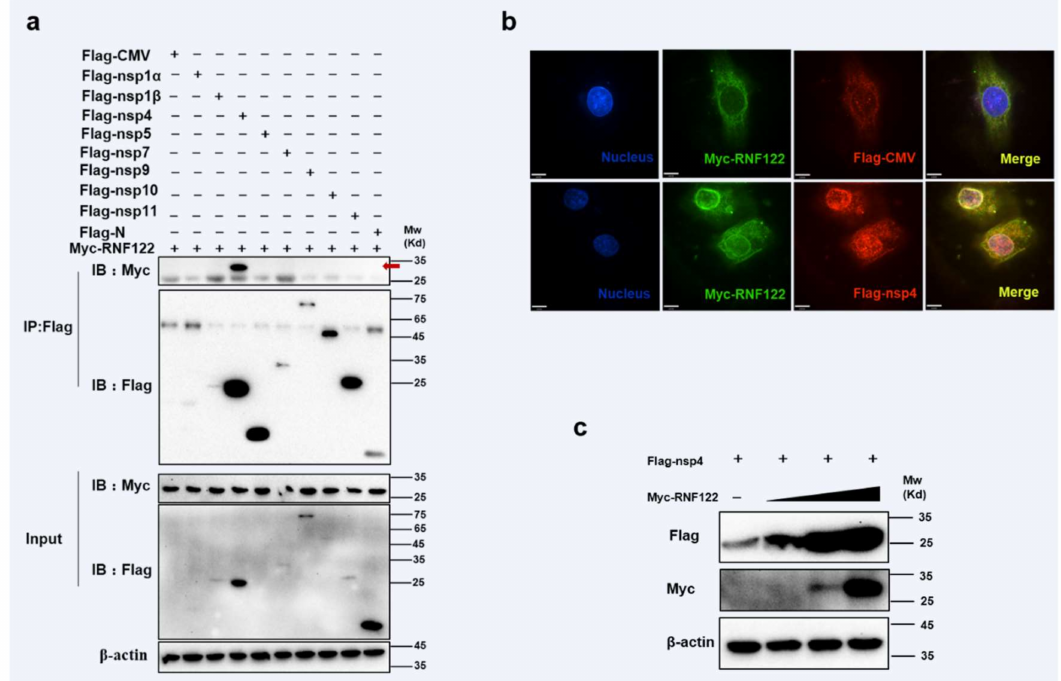
Figure 6. Interaction between porcine RNF122 and PRRSV nsp4. ( a ) HEK293T cells were co- transfected with Myc-RNF122 and Flag-nsp1 α , Flag-nsp4, Flag-nsp5, Flag-nsp7, Flag-nsp9, Flag- nsp10, Flag-nsp11, Flag-N or Flag-CMV. Flag Beads were used for CO-IP 24 h after transfection and further detected by Western blotting with an anti-Flag antibody and an anti-Myc antibody, respectively. Red arrow represents interaction bands. ( b ) 3D4/21 cells were placed on cover slips in 12-well plates and co-transfected with the Myc-RNF122 and Flag-nsp4 or Flag-CMV, respectively. Fixed double-stained with a mouse anti-Myc mAb and a rabbit anti-Flag antibody, and attended by FITC-conjugated anti-mouse IgG (green) and PE-conjugated anti-rabbit IgG (red). Nuclei were stained with DAPI (blue). Fluorescence confocal microscopy (UltraView Vox, PerkinElmer, Waltham, MA, USA) was used to detect the co-location. ( c ) HEK293T cells were co-transfected with Flag-nsp4 (1 µ g) and Myc-RNF122 (0 µ g, 0.1 µ g, 0.5 µ g, 1 µ g), 24 h later, the protein expression was tested by